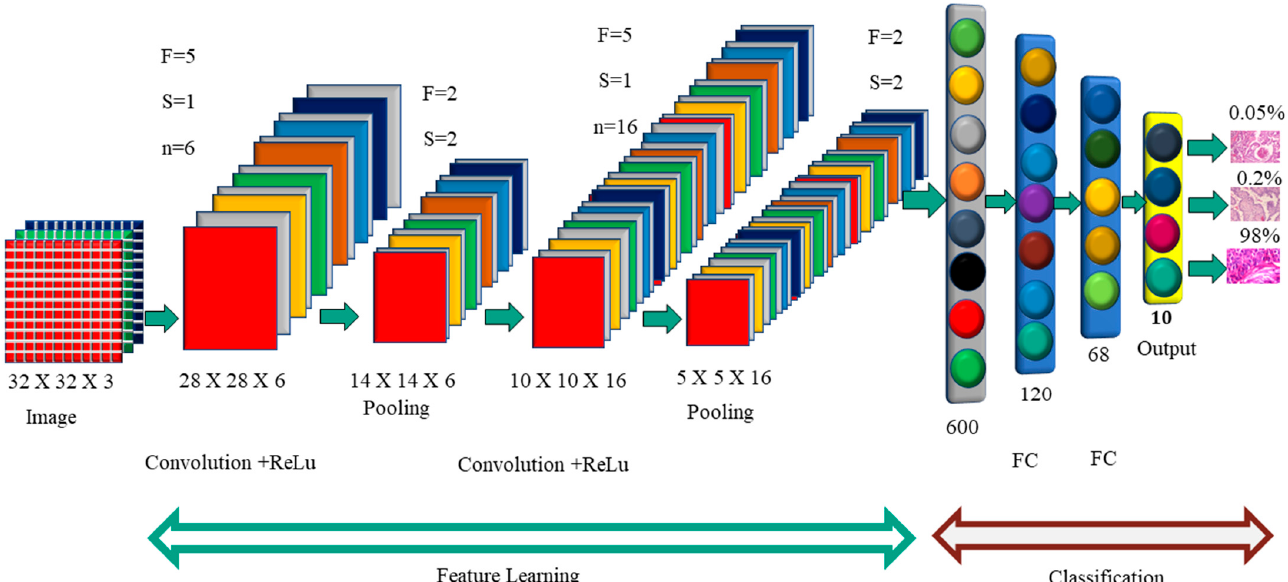
Figure 2. Convolution Neural Network